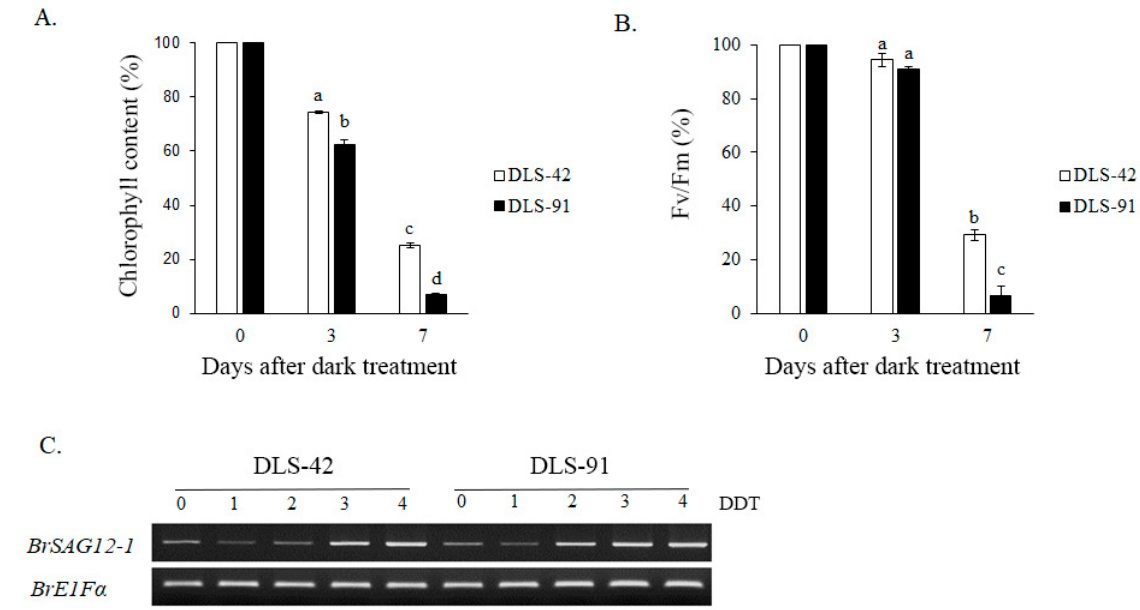
Figure 2. Phenotypic changes during dark-induced leaf senescence. Variation in ( A ) chlorophyll content, ( B ) photochemical efficiency ( F v /F m ), and ( C ) expression of the senescence-related marker SAG12-1 (with EF1- α as a reference gene). Data is the mean of three independent experiments. Error bars represent standard deviation of three biological replicates. Different letters indicate significant differences. One-way ANOVA test is performed using SPSS software. DAT, days of dark treatment.